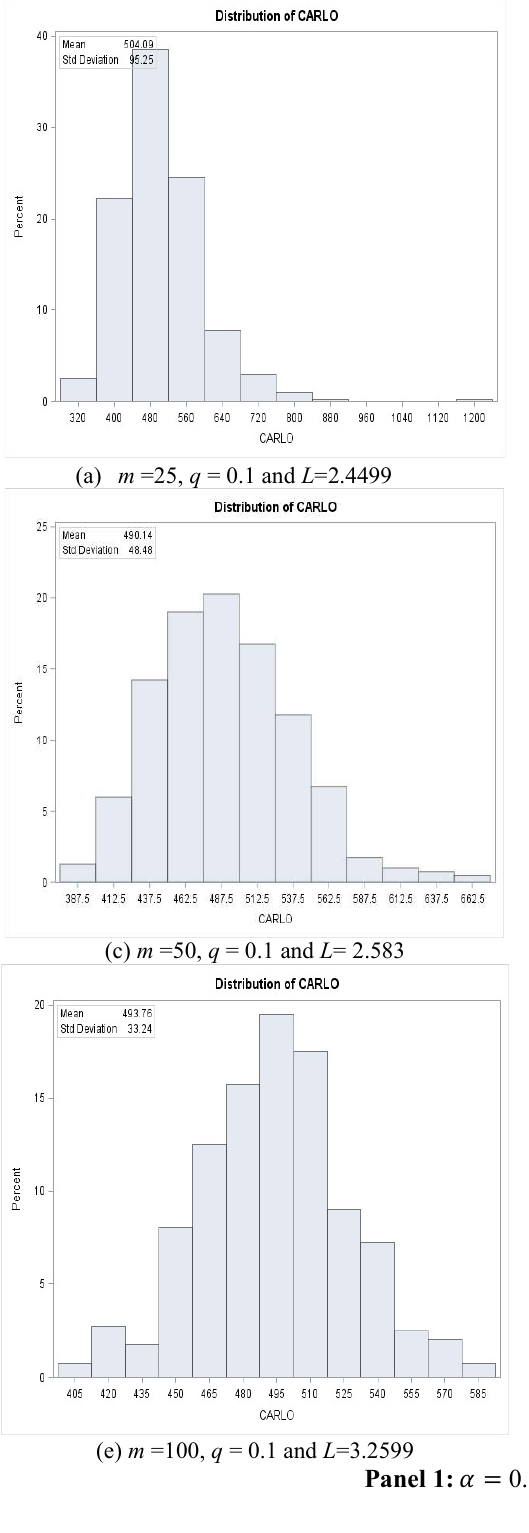
(a) m =25, q = 0.1 and L =2.4499 (b) m =25, q = 0.9 and L =2.321